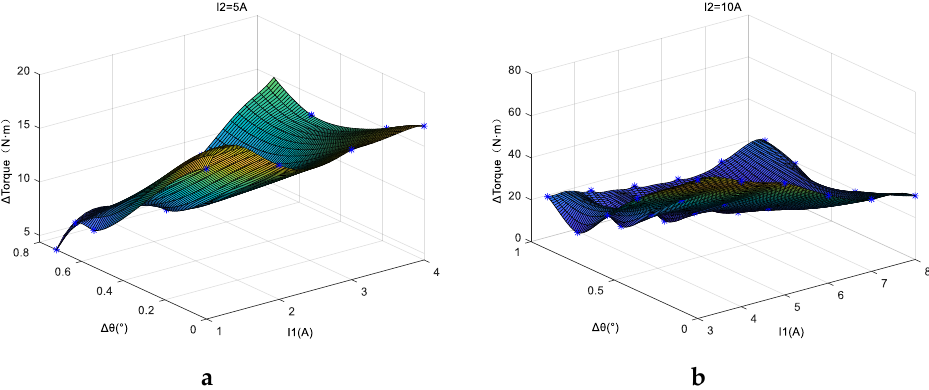
Figure 8. Torque ripple characteristics corresponding to different Δ θ and I 1 : ( a ) I 2 = 5 A ( b ) I 2 = 10 A.